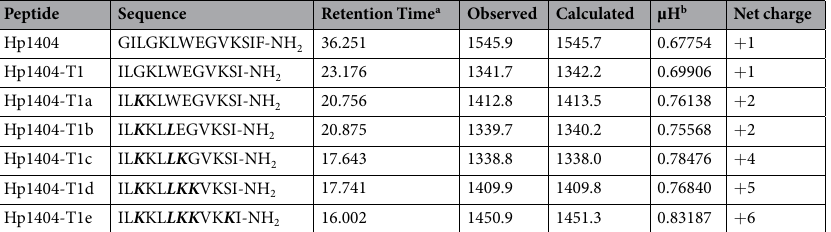
Table 1. Sequence and physicochemical parameters of Hp1404 and its synthetic analogue peptides. a Mean retention time (min) in reversed-phase high performance liquid chromatography (RP-HPLC). b Hydrophobic moment ( µ H) was calculated using the HeliQuest